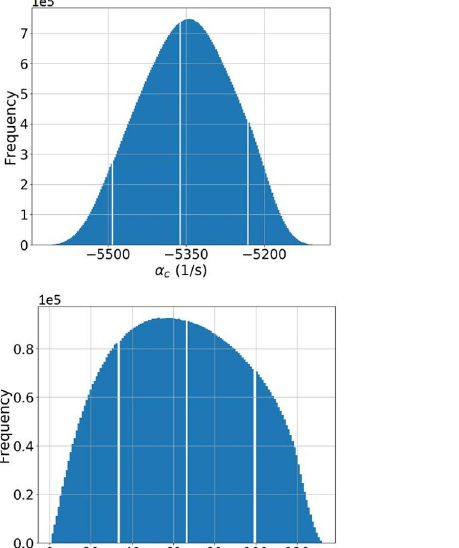
Values for the 286.6 ppm case.